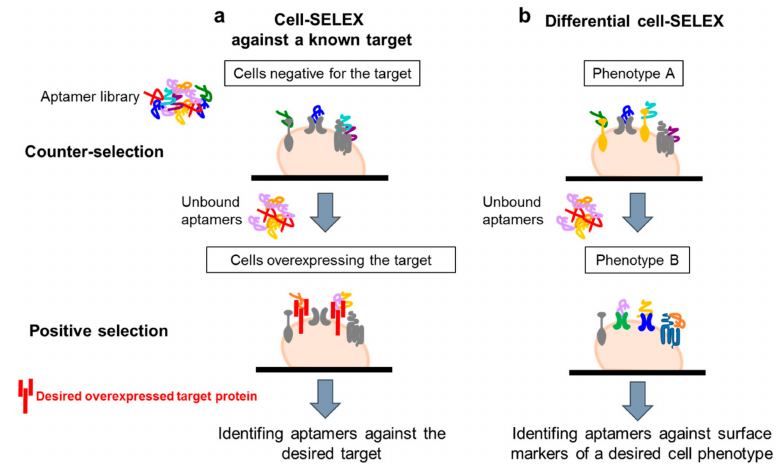
Figure 2. Cell-SELEX variants. Scheme of the two main variants of cell-SELEX: ( a ) protocol to select aptamers against a known target by using in the selection step a cell line over-expressing the target; ( b ) protocol to identify multiple ligands specifically recognizing a cell phenotype, without prior knowledge of the target